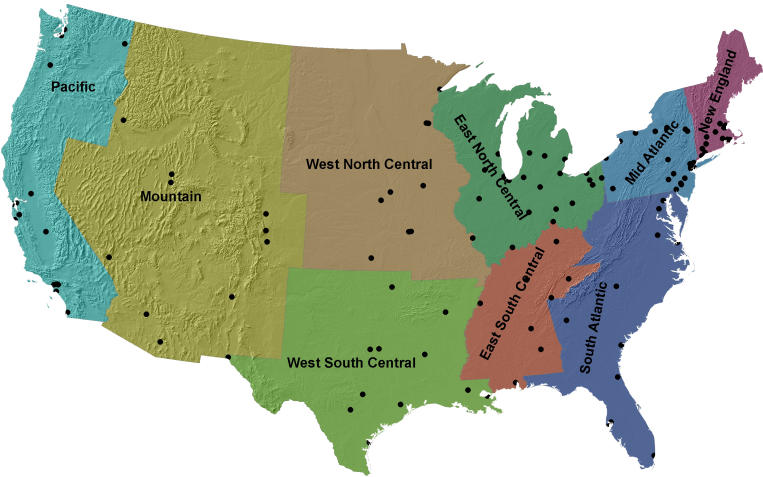
Major Geographic Regions of the United StatesThe sentinel cities that report mortality due to P&I used in the Centers for Disease Control and Prevention 122 Cities Mortality Reporting System are displayed (black dots). Because the strength of the seasonal influenza cycle is weak for cities with small case counts and because some city data contain missing data points, we aggregated the raw city-level data to obtain composite waveforms by major geographic region, the aerial unit of analysis for this study.